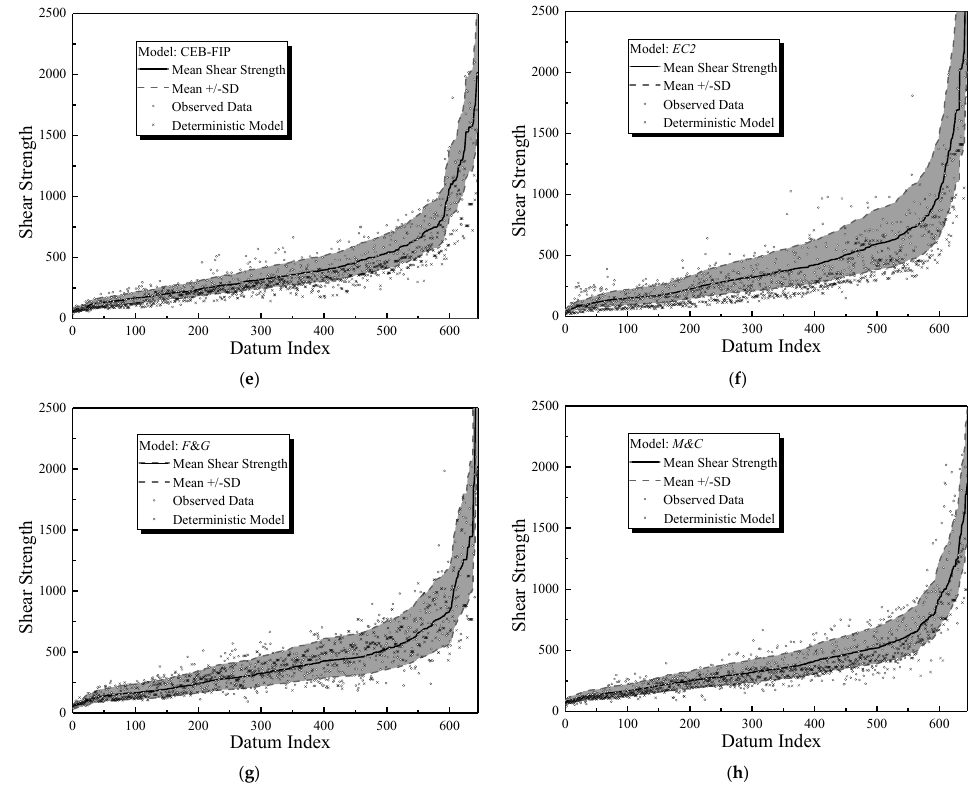
Figure 5. Performance of the probabilistic models at each experimental data. ( a ) The Proposed Model. ( b ) ACI 318-14. ( c ) GB 50010-10. ( d ) CSA 23.3-04. ( e ) CEB-FIP. ( f ) EC2. ( g ) Foster and Gilbert. ( h ) Mitchell and Collins.